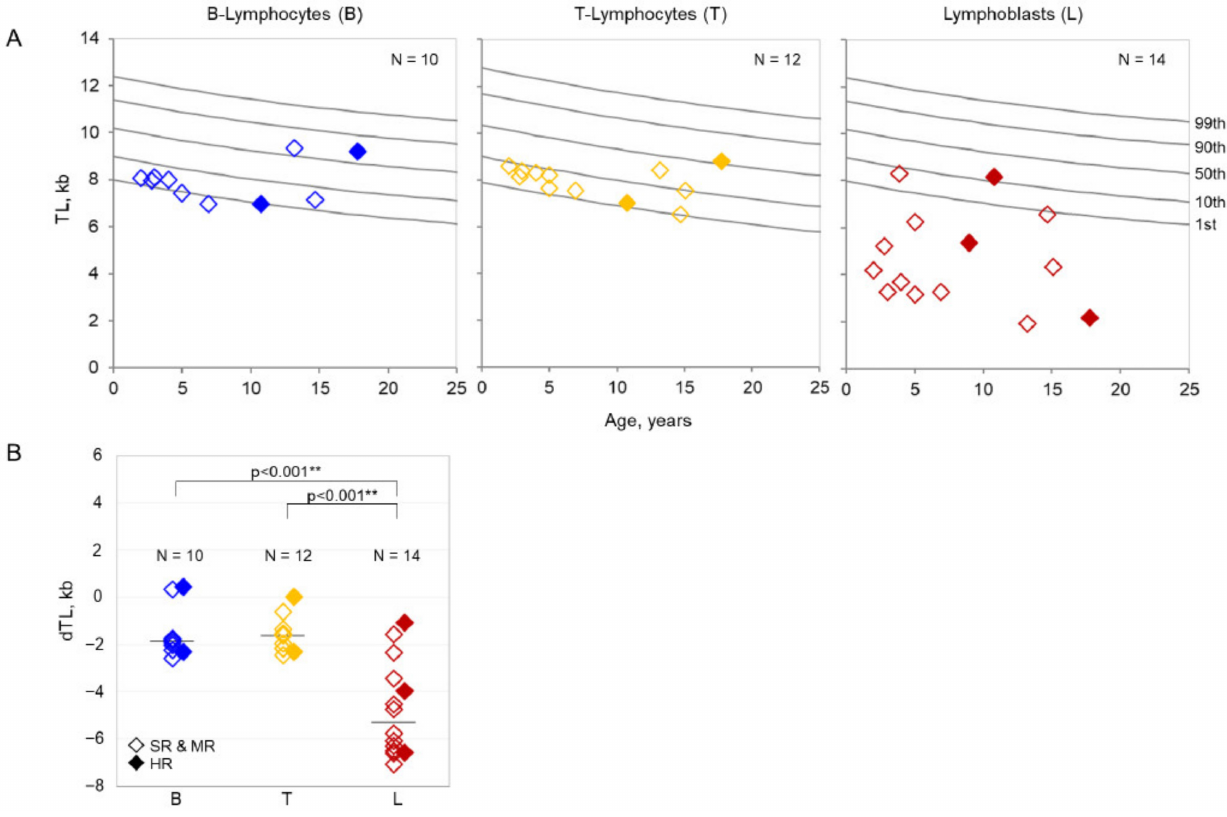
Figure 2. ( A ). Absolute telomere lengths of pediatric patients. Telomere lengths (TLs) in lymphoblasts (L) ( right panel ) compared to B-lymphocytes (B) ( left panel ) and T-lymphocytes (T) ( central panel ) in pediatric patients with ALL in relation to reference percentiles (grey lines) established from TLs of over 400 healthy individuals. ( B ). Age-adjusted telomere lengths of pediatric patients. Age-adjusted difference in telomere lengths (dTLs) in lymphoblasts (L) (right column) compared to B-lymphocytes (B) (left column) and T-lymphocytes (T) (central column). Pediatric patients with high risk (HR) are represented by filled diamonds, patients with standard risk (SR) and medium risk (MR) are represented by transparent diamonds. ** p <